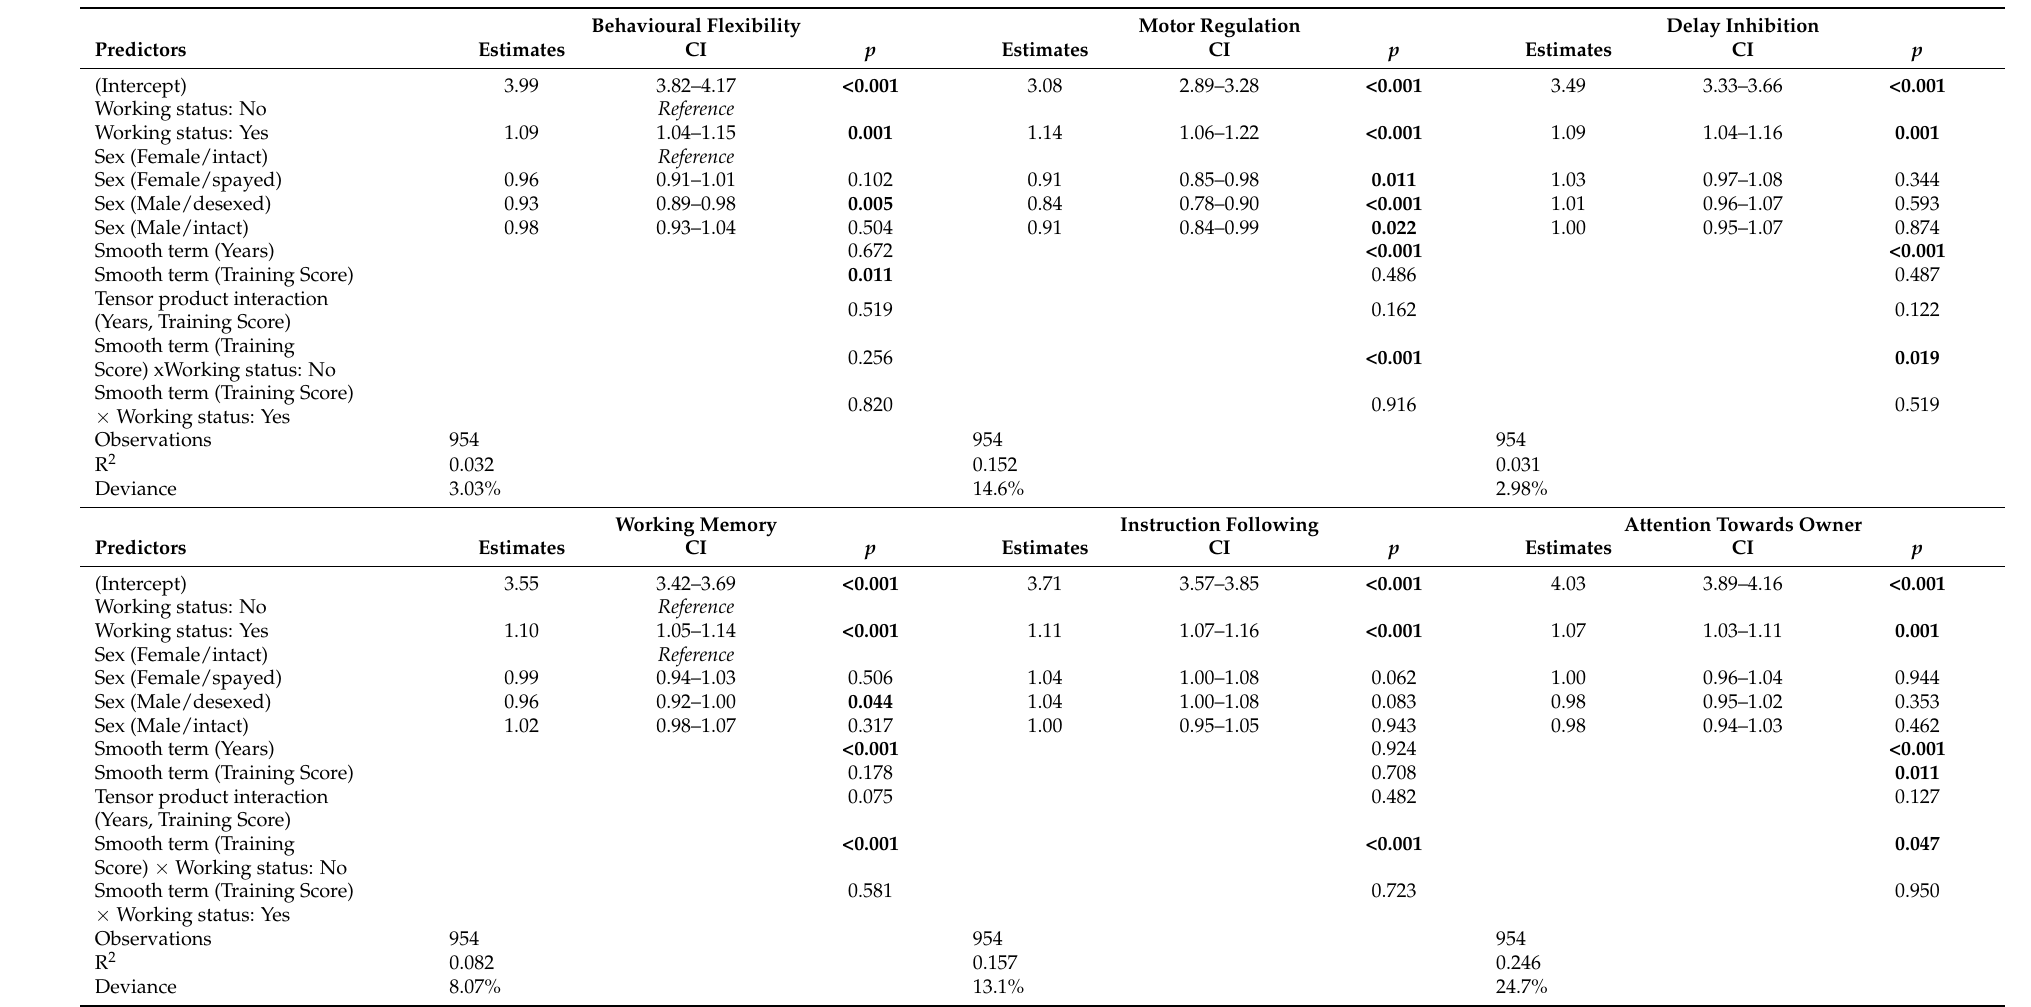
Table 3. Generalised additive model results for DEFS subscales. Significant p -values are marked in